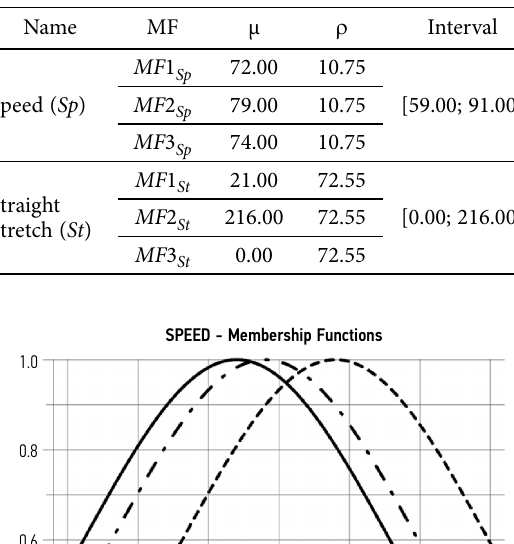
Table 4. Characteristics of the input membership functions